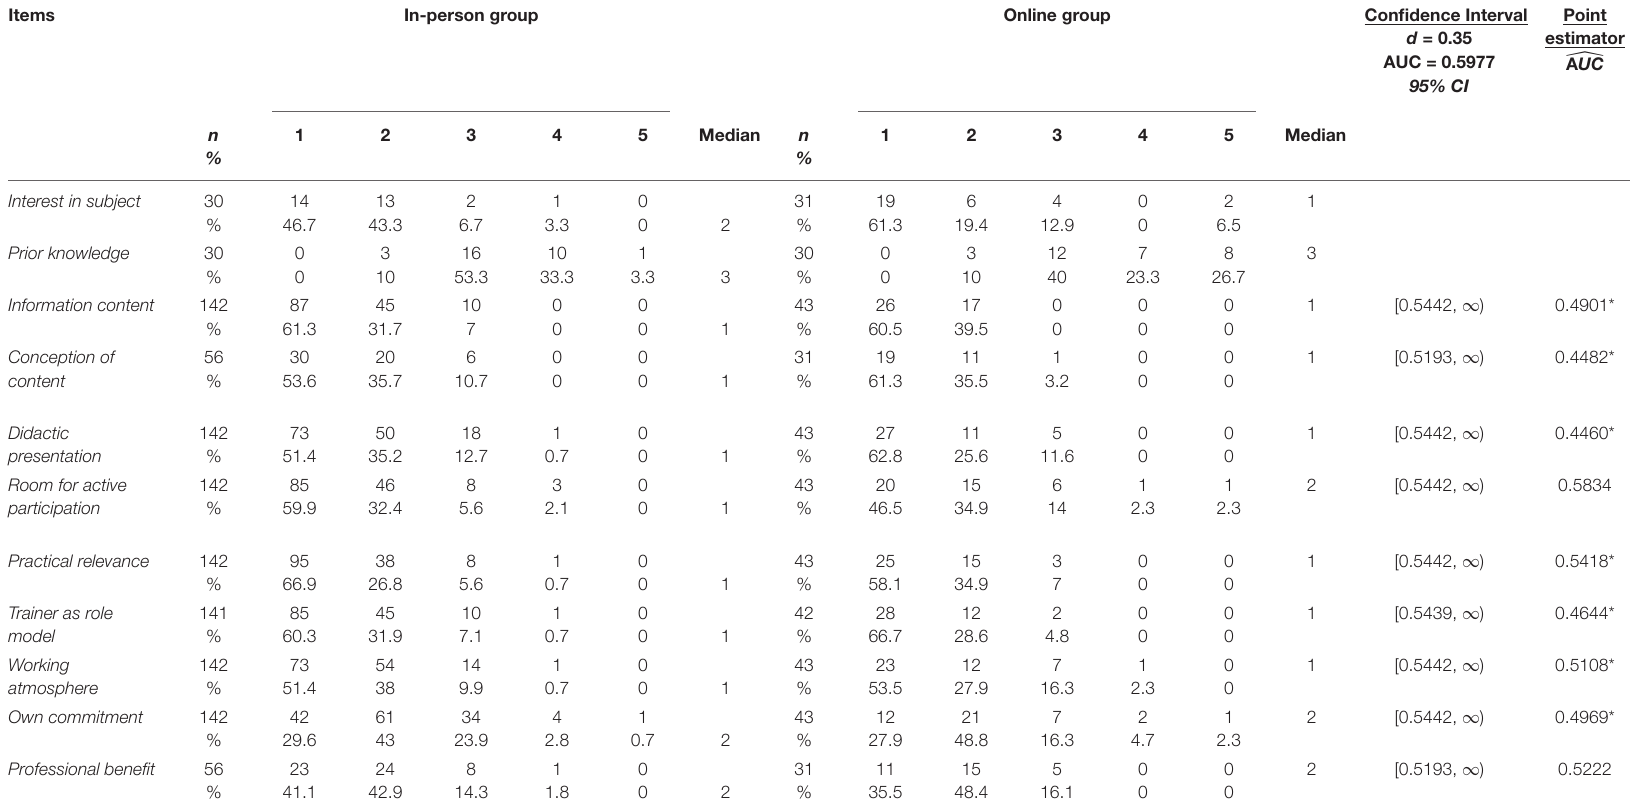
TABLE 1 | Ratings for online vs. In-person workshops and results of the non-inferiority analysis.